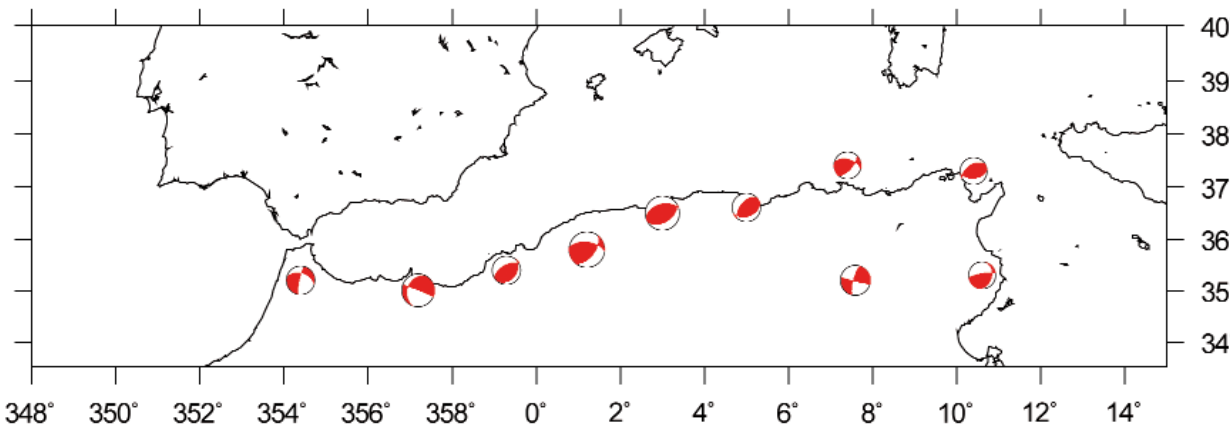
Figure 3. Composite focal mechanisms from the moment tensor summations, as computed for each tectonic zone defined in Figure 1b [Pondrelli et al. 1995, Pondrelli 1999, Pondrelli et al. 2011]. Northwestern Algeria shows a consistent pattern of thrust mechanisms, in agreement with the Tell Atlas thrust-and-fold active belt. The seismic parameters are reported in Table